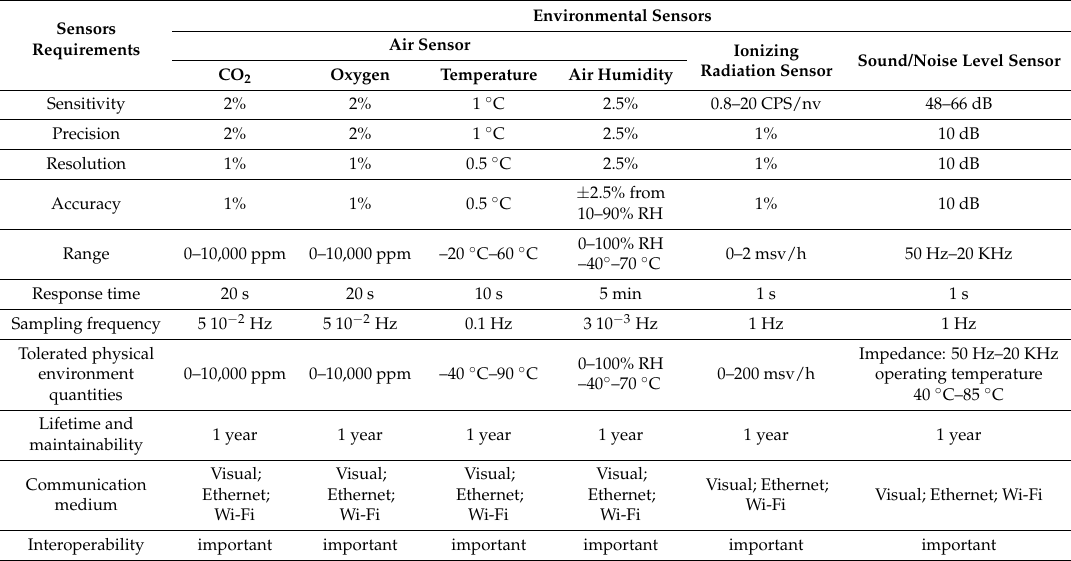
Table 1. High level requirements for environmental sensors.